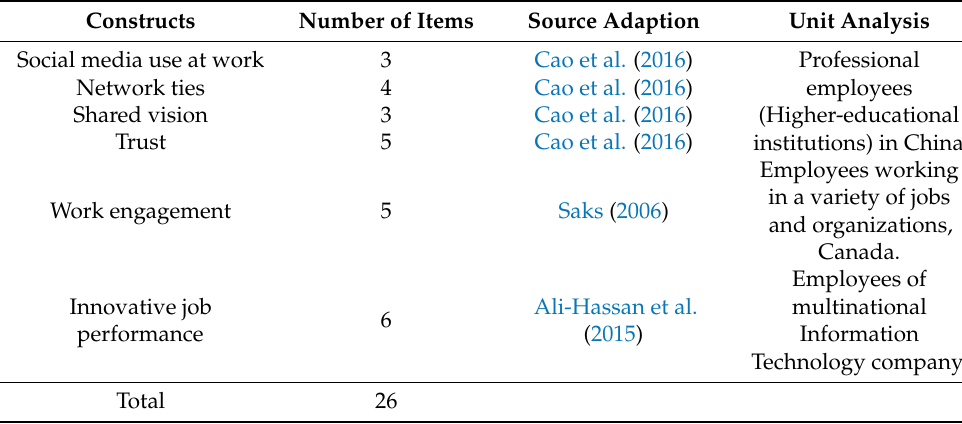
Table 1. The list of variables measured in this